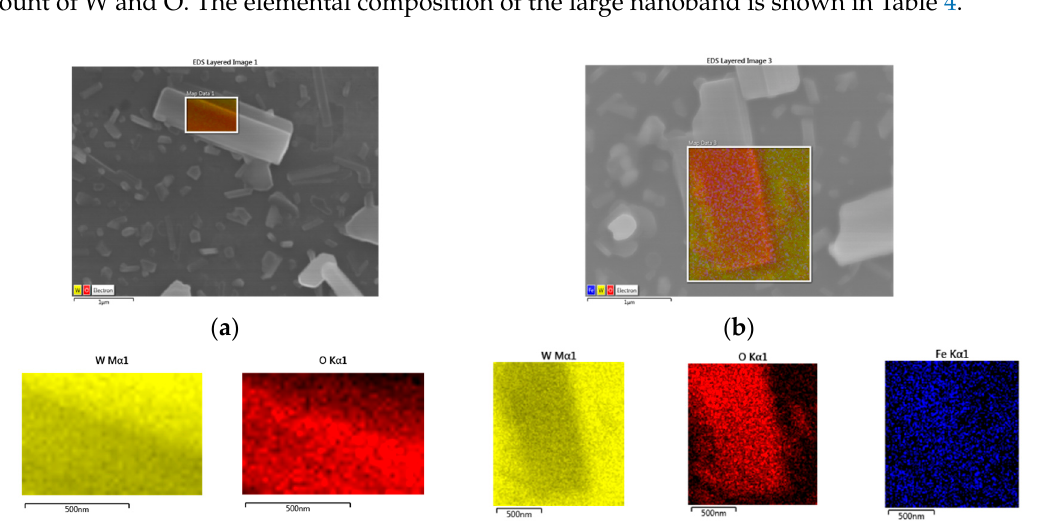
Figure 5. The EDX mapping of the S2 sample at T = 750 ° C. ( a ) EDX mapping on a large nanoband; ( b ) EDX mapping made on a large nanoband and slice of the film surface. Table 4. The elemental composition of the S2 sample annealed at T = 750 °C , on the large nanoband, and large nanoband with a slice of the film surface.